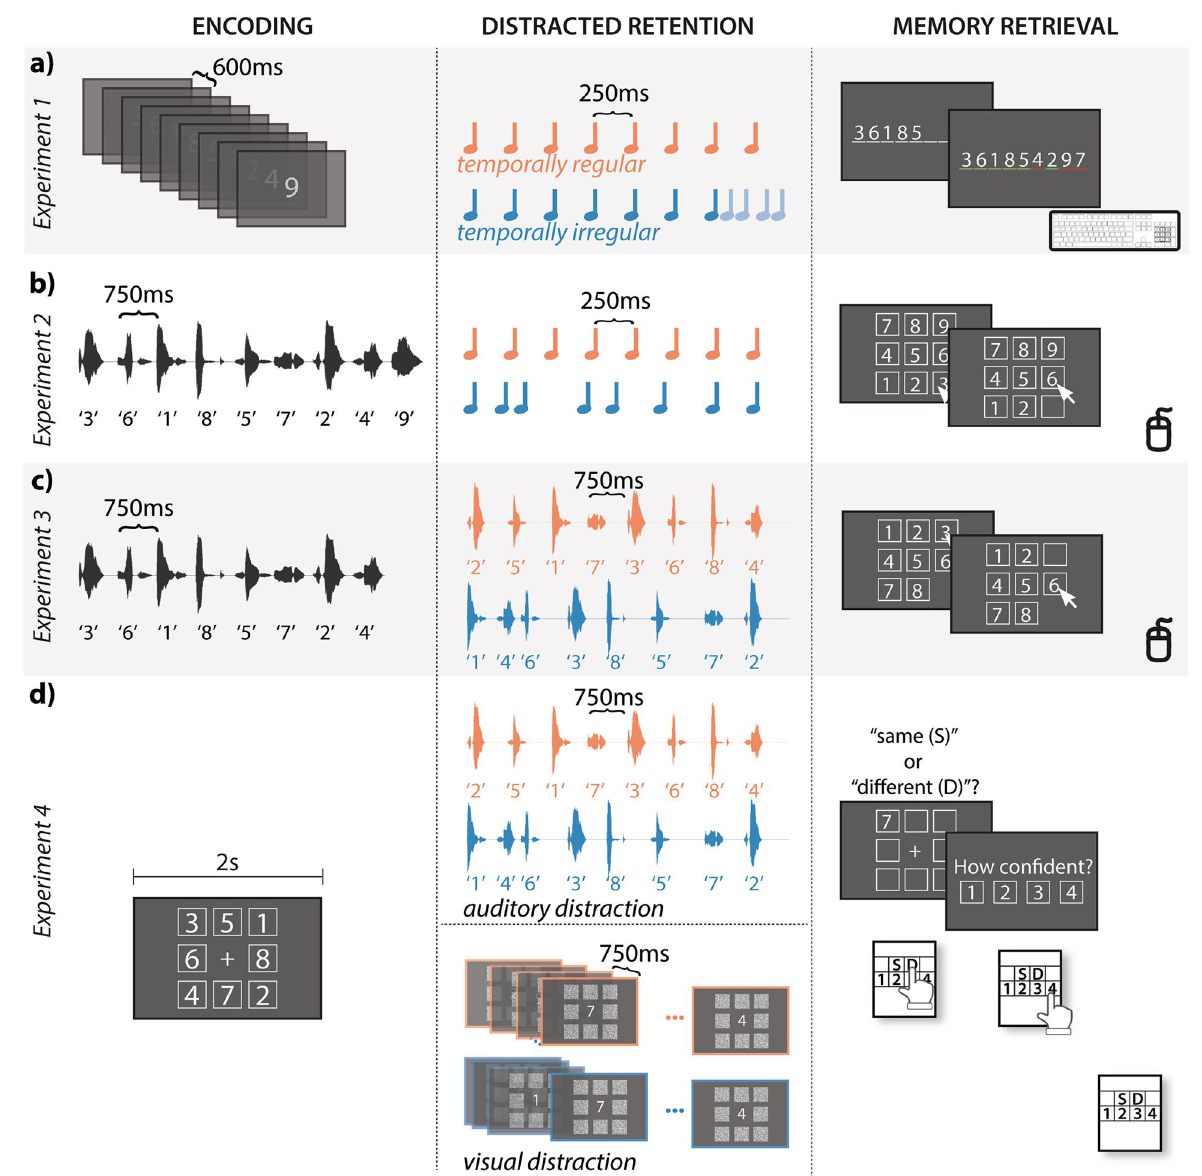
Figure 1. In all four experiments ( a – d ), participants maintained the target numbers in memory during the retention period while ignoring the distractors (blue/orange). In Experiment 1 ( a ), temporal regularity of distractors was manipulated by altering the onset of the last distractor tone such that it was either identical (regular, orange), or shorter/longer (irregular, blue) than the stimulus onset asynchrony of the preceding distractor sequence. In Experiments 2 to 4 ( b – d ), temporal regularity of the distractors was operationalized by isochronous (regular, orange) or irregular (blue) temporal structure of the entire sequence of distractors. After the retention period, participants responded with a mouse to select the numbers in their order of presentation from a visually presented number pad (Experiments 2 and 3), with a number pad on a keyboard (Experiment 1), or with a response pad (Experiment